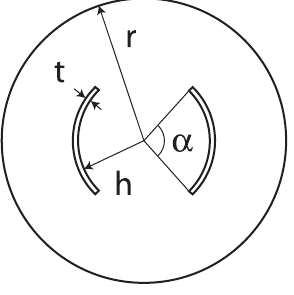
FIG. 8. Strip-line cross section in field computation. α is the coverage angle, h is the strip-line aperture radius, t is the strip-line thickness, and r is the outer vacuum chamber